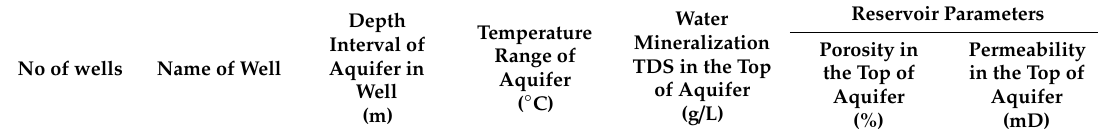
Table 1. Selected hydrogeothermal parameters of the “Lower Carboniferous-Devonian” aquifer in wells with the inflow of thermal waters in the area of the Silesia–Krakow region (after well data derived from Polish Geological Institute, PGNiG and